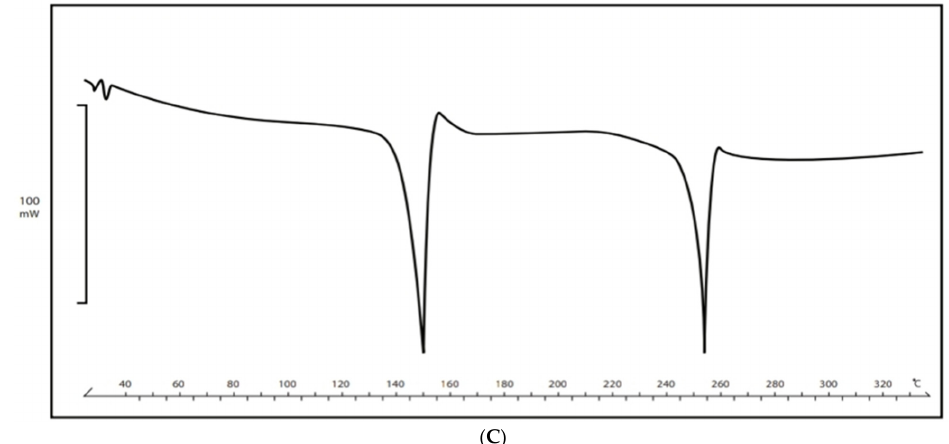
Figure 4. ( A ) DSC thermogram of pantoprazole. ( B ) DSC thermogram of meloxicam. ( C ) DSC thermogram of a combination between meloxicam and pantoprazole retained the characteristic peaks of the DSC thermogram for both drugs, indicating little or no interaction.